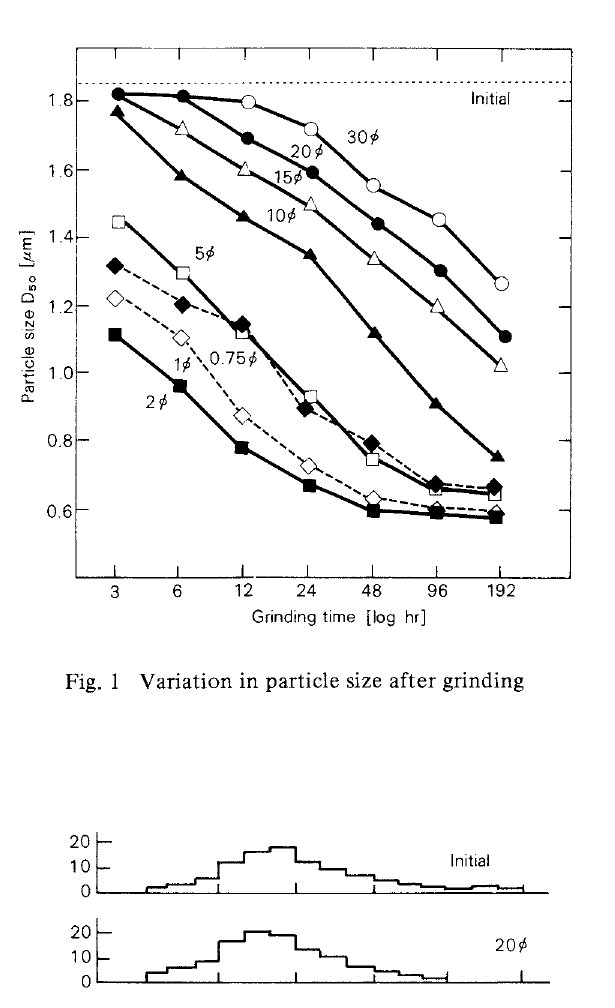
Fig. 1 Variation in particle size after grinding